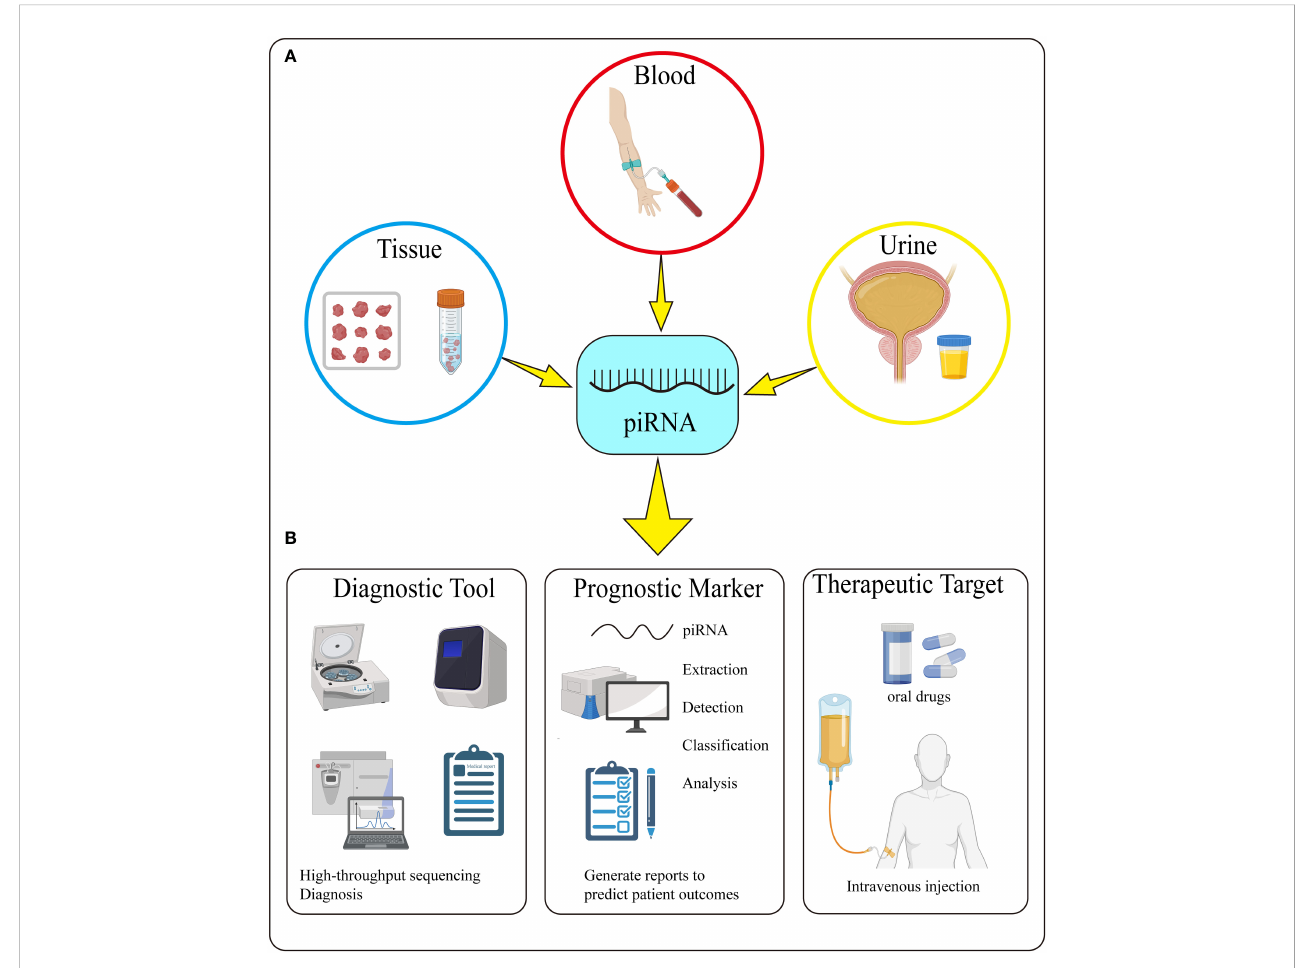
FIGURE 4 Detection and Potential Application of piRNA. (A) piRNA can be detected in tissue, blood, and urine. (B) piRNA can be used as a diagnostic tool, prognostic marker and therapeutic target through its extraction, detection, classi fi cation and